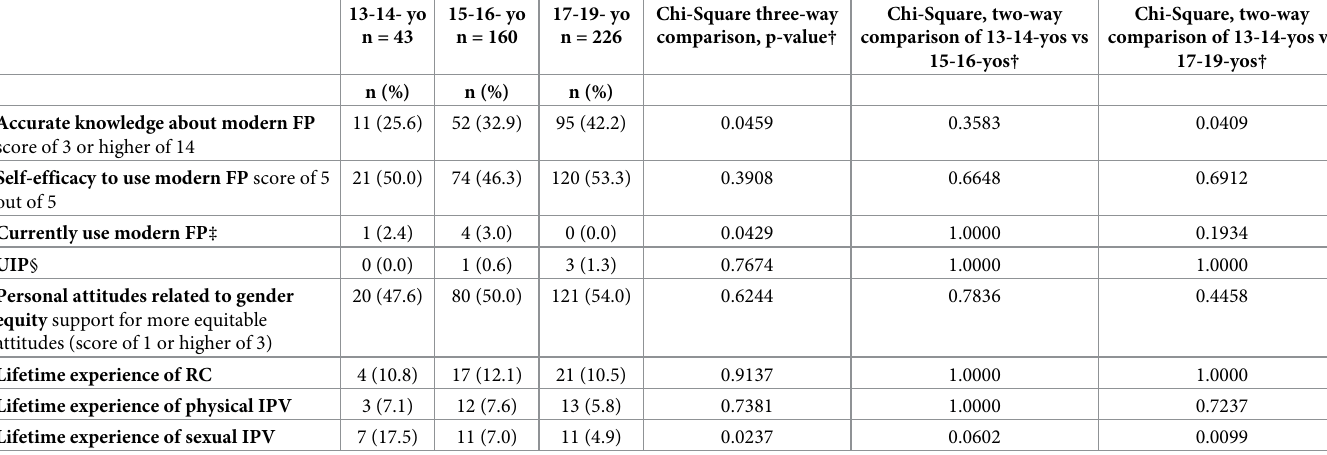
Table 4. Frequency of reproductive health, gender equity, and partner violence factors experienced among married AGYWs in Dosso region, Niger, by age group, among the nulliparous � .